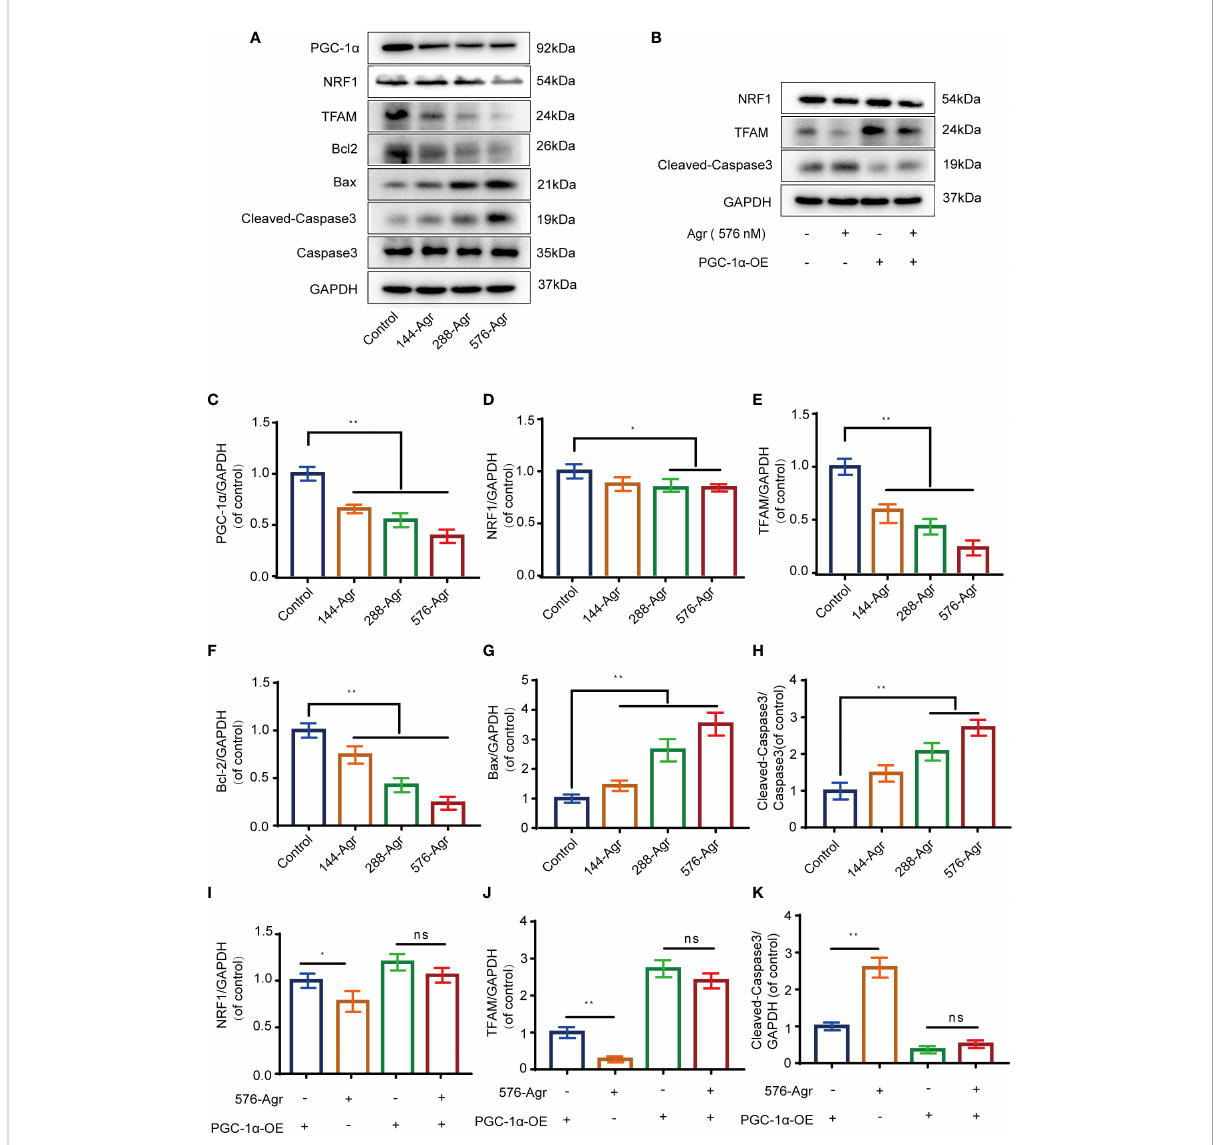
FIGURE 4 Agr reduces PGC-1 a activation and NRF1 and TFAM expression of HCT116 cells in vitro . (A) After HCT116 cells were treated with different doses of Agr (0, 144, 288, and 576 nM) for 48 h, the protein levels of PGC-1 a , NRF1, TFAM, Bax, Caspase-3, Bcl-2, and Cleaved-Caspase-3 were analyzed using Western blotting analysis. (B) After preliminary treatment of HCT116 cells with PGC-1 a -OE for 30 min and treatment with 576 nM Agr for 48 h, the protein levels of NRF1, TFAM, and Cleaved-Caspase-3 protein were analyzed by Western blotting analysis. (C) Quantitative data for the ratio of PGC-1 a to internal control protein (GAPDH). ** p < 0.01 versus control. (D) Quantitative data for the ratio of NRF1 to GAPDH. * p < 0.05 compared with the control. (E) Quantitative data for the ratio of TFAM to GAPDH. ** p < 0.01 compared with the control. (F) Quantitative data for the ratio of antiapoptotic proteins (Bcl-2) to internal control protein (GAPDH). ** p < 0.01 versus control. (G) Quantitative data for the ratio of proapoptotic proteins (Bax) to internal control protein (GAPDH). ** p < 0.01 versus control. (H) Quantitative data for the ratio of Caspase-3 to Cleaved-Caspase-3. ** p < 0.01 versus control. (I) The protein levels of NRF1 were quanti fi ed by ImageJ. * p < 0.05, ns = no signi fi cant difference compared with the control. (J) The protein levels of TFAM were quanti fi ed using ImageJ. * p < 0.05, ns = no signi fi cant difference. (K) The protein levels of Cleaved-Caspase-3 were quanti fi ed using ImageJ. * p < 0.05, ns = no signi fi cant difference. The results are shown as mean ± SD ( n = 3, each group). Agr, agrimol B; PGC-1 a , peroxisome proliferator-activated receptor- g coactivator 1 a ; NRF1, nuclear respiratory factor 1; TFAM, mitochondria transcription factor